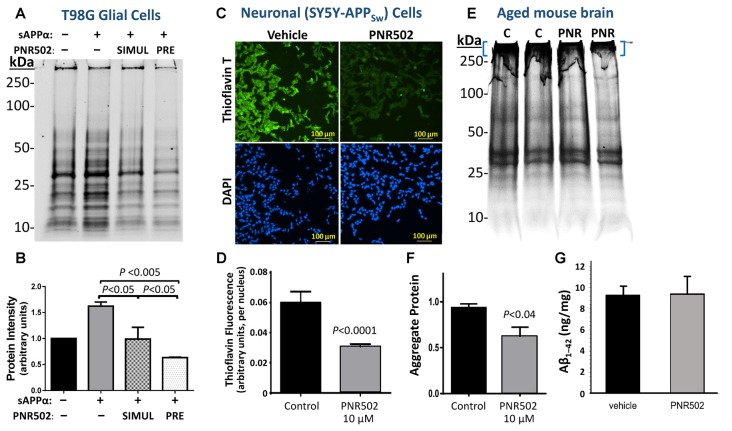
PNR502 reduces protein aggregation in human glial and neuronal cells in culture, and in mouse cerebra in vivo. (A,B) T98G human glial cells were cultured 26 h either untreated or in the presence of 30-nM sAPPα. The right two lanes are from cells with either prior or simultaneous addition of 10-nM PNR502. Untreated cells received vehicle alone (controls). Insoluble aggregates were then isolated and their full-lane protein content was quantified by SYPRO-Ruby staining (Thermo Fisher Scientific, Waltham, MA, USA) of electrophoresed proteins (N = 5 per group). Error bars show standard deviations; P-values are from 2-tailed heteroscedastic t-tests. (C,D) SY5Y-APPSw human neuroblastoma cells were cultured for 2 days in the presence or absence of 5-μM PNR502, after which amyloid was stained with Thioflavin T and quantified from fluorescence images (see “Materials and Methods” section). Significance of differences from controls was determined by 2-tailed heteroscedastic t-tests. (E,F) Sarcosyl-insoluble aggregates were isolated from cerebra of adult (12-month-old) mice that had been injected I.P. with vehicle or PNR502 (5.7 μM/kg/day) for 10 successive days. Aggregates were resuspended in Laemmli buffer (2% SDS, 50-mM β-mecaptoethanol) at 95°C electrophoresed in SDS/polyacrylamide gels, and stained with SYPRO Ruby. (F) Protein staining is summarized for sarcosyl-insoluble aggregates isolated from mouse cerebra (N = 5 per group). Only protein complexes of very low mobility (blue brackets in E) were considered in this quantitation, but the reduction in intensity after PNR502 was similar for gel regions of higher mobility, and for full-lane scans (not shown). (G) Total Aβ1–42 in mouse cerebra, quantified with primary and fluor-tagged secondary antibodies, was not affected by PNR502 injections.